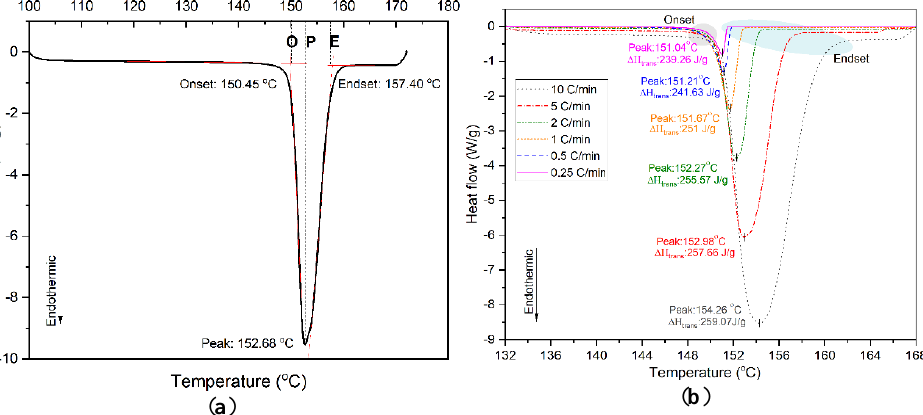
Figure 8. PCM’s transition peak: ( a ) transition temperatures, ( b ) shifting the end of transition toward a higher temperature. (Personal data for adipic